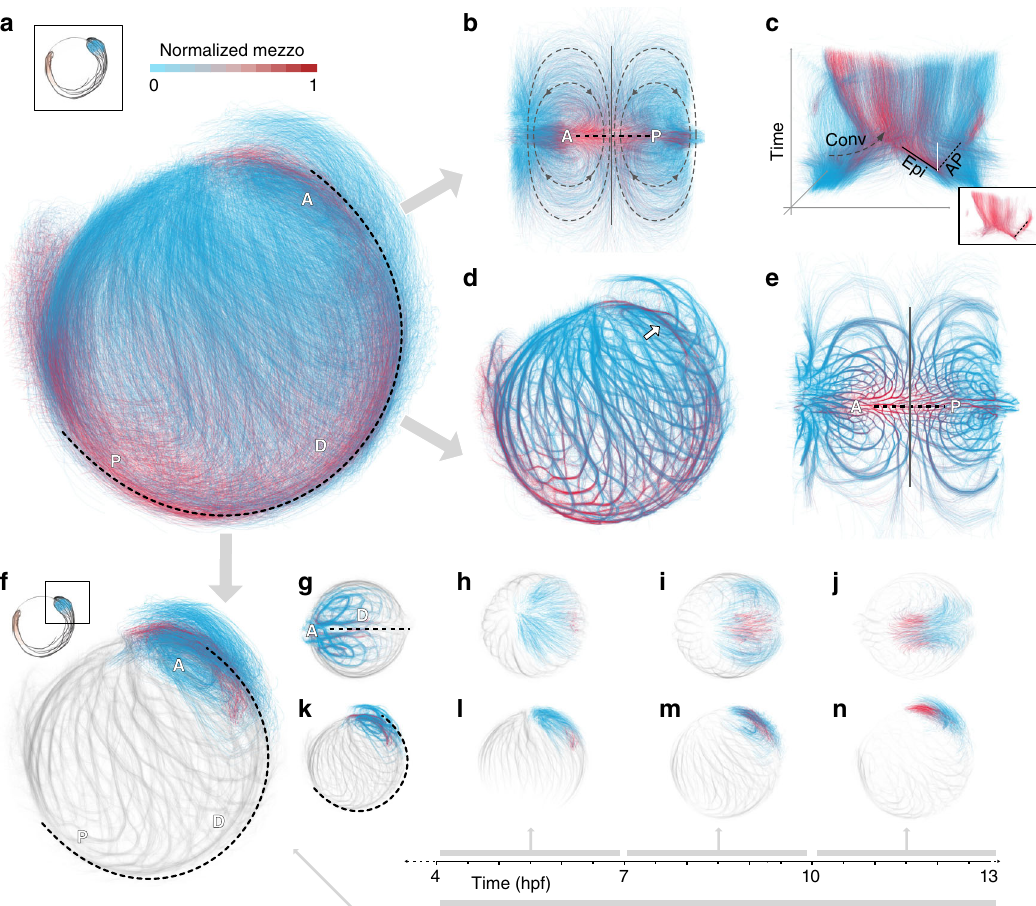
Fig. 5 Exploratory data analysis of long-term pan embryo cell dynamics. a 3D rendering of long-term cell trajectories (A-anterior, P-posterior, dashed curve-dorsal midline). Color code shows normalized mezzo expression along each track. b 2D Mercator projection of cell tracks (A-anterior, P-posterior, dashed line-dorsal midline), same color code as in a . Principal directions for convergence (dashed-gray) movement and border separating the anterior and posterior fl ows (solid line along the left-right axis) are shown as overlays. c Space-time plots of long-term tracks over Mercator projection. Z -axis corresponds to time. Gray, dashed arrow illustrates the convergence movement (Conv). Dashed black line highlights movement of mesendodermal cells moving towards animal pole (AP). Solid black line indicates movement of mesendodermal cells undergoing epiboly (Epi). White line shows space-time line of a stationary object for reference. Inset shows subpopulation of cells with high normalized mezzo expression. Same color code as in a . d 3D rendering of bundled, long-term cell trajectories assembled from individual cell tracks (A-anterior, P-posterior, dashed curve-dorsal midline) highlighting structural details of cell migration patterns from 4 to 13 hpf. Color code shows normalized mezzo expression along track. Arrow indicates the internalized stream of mesendodermal cells towards animal pole. e 2D Mercator projection of bundled cell tracks reveals global structure of migration patterns across the developing embryo from 4 to 13 hpf (A-anterior, P-posterior, dashed line – dorsal midline). Border separating the anterior and posterior fl ows (solid line along the left-right axis) are shown as overlay. f Lateral view of selected anatomical region of interest. Long-term trajectories of cells within ROI are shown for 4 – 13 hpf time interval. Color code indicates normalized mezzo expression. Cell tracks outside of ROI shown as bundled tracks in gray. g Rotated, dorsal view of selected cell tracks shown in bundled state to highlight structure of cellular fl ows. h – j Backtracking of cells in ROI in time intervals of 90 min. Same color code as f . Tracks outside of region of interest are shown as gray bundles. k – n Lateral view of selected cell tracks, same visual coding as in g – j